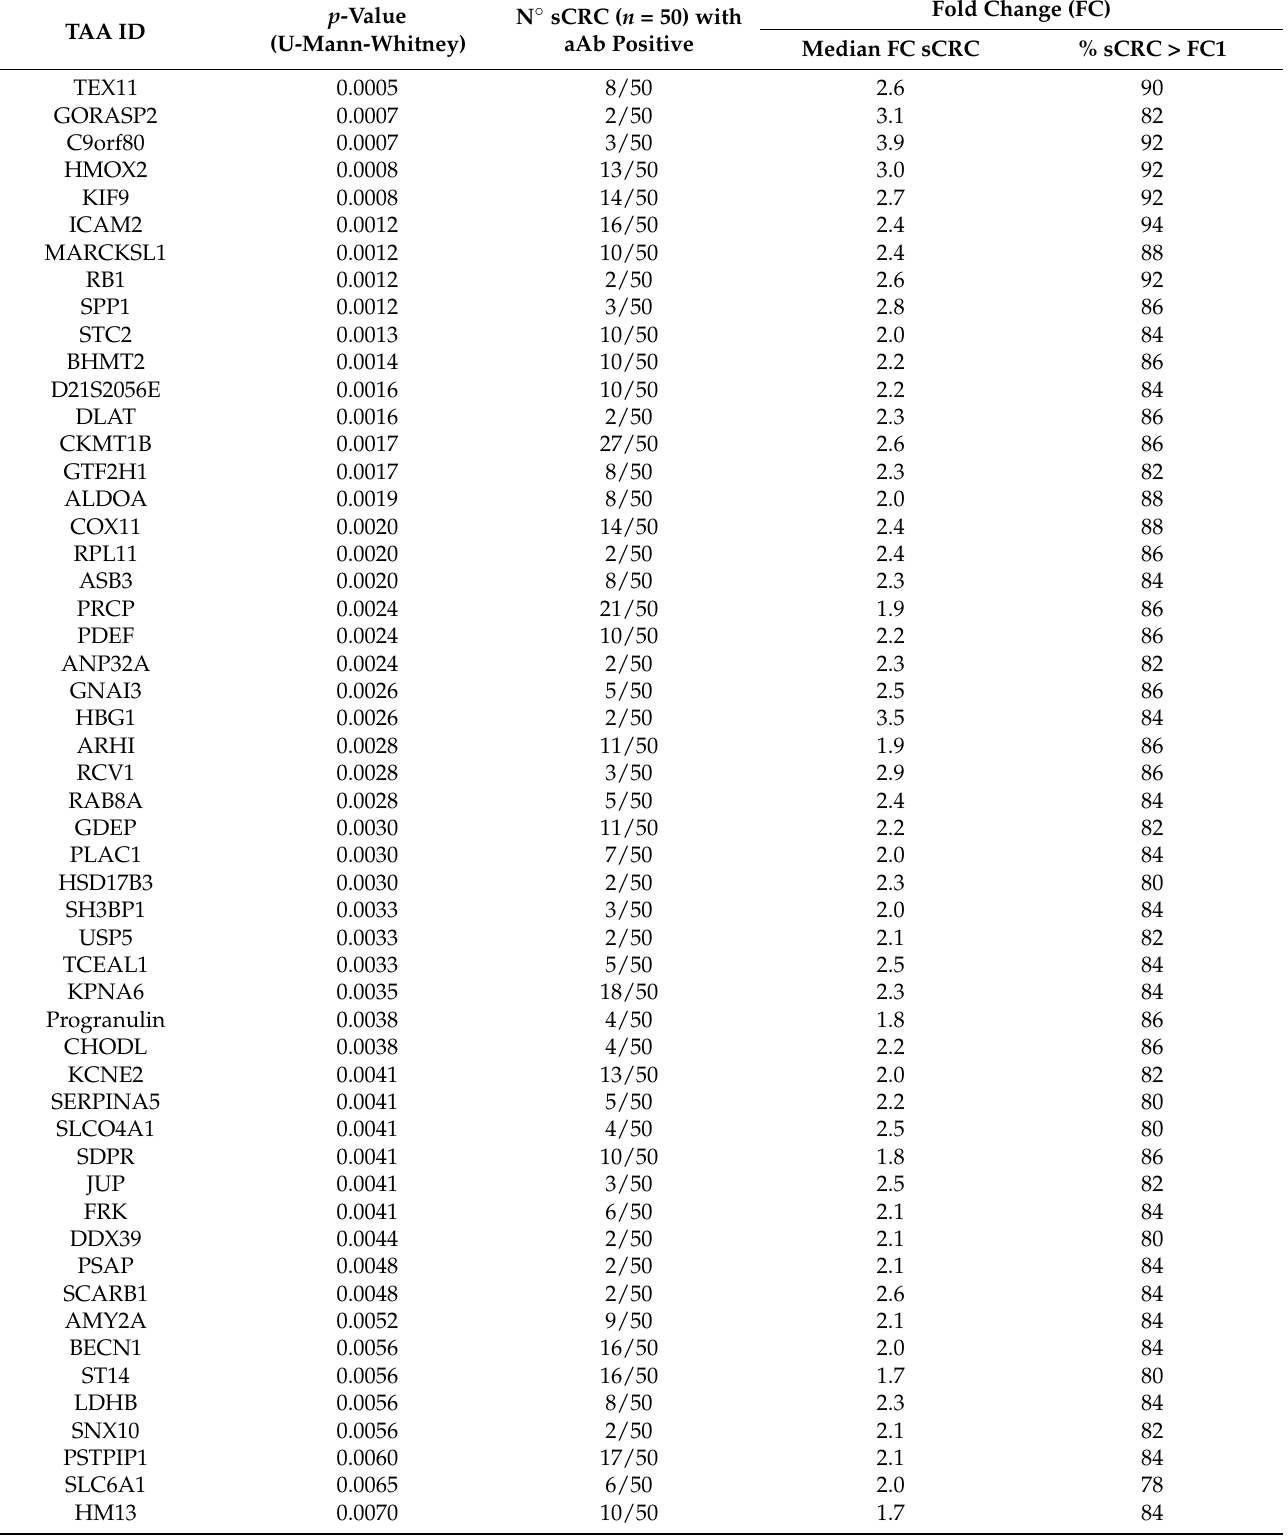
Table 3. aAbs profile against 67 TAAs with statistical significance ( p < 0.01) that might discriminate healthy donors (negative colonoscopy) ( n = 7) vs. sCRC patients ( n = 50). None of these TAAs have been detected as positive aAb in healthy